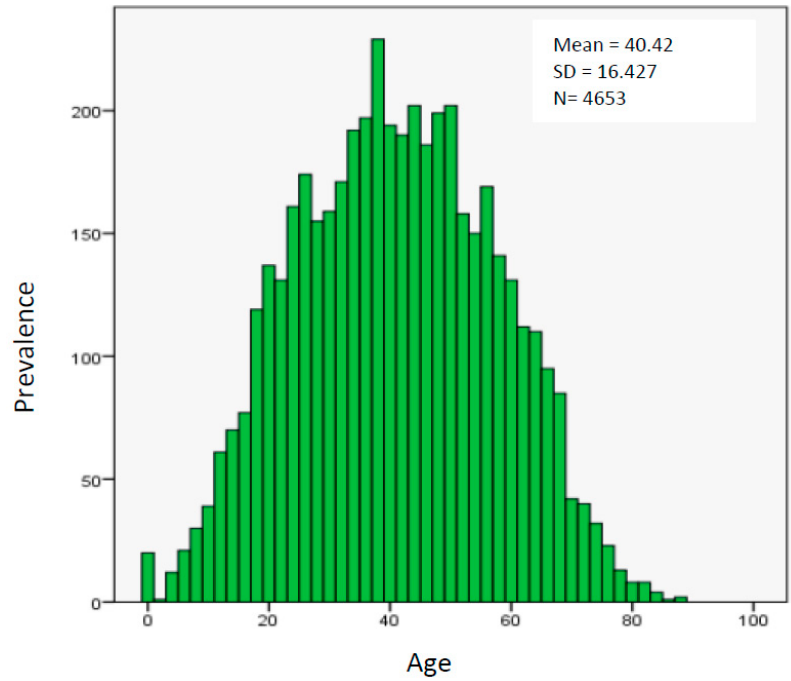
Figure 2. Age distribution of whole cohort.